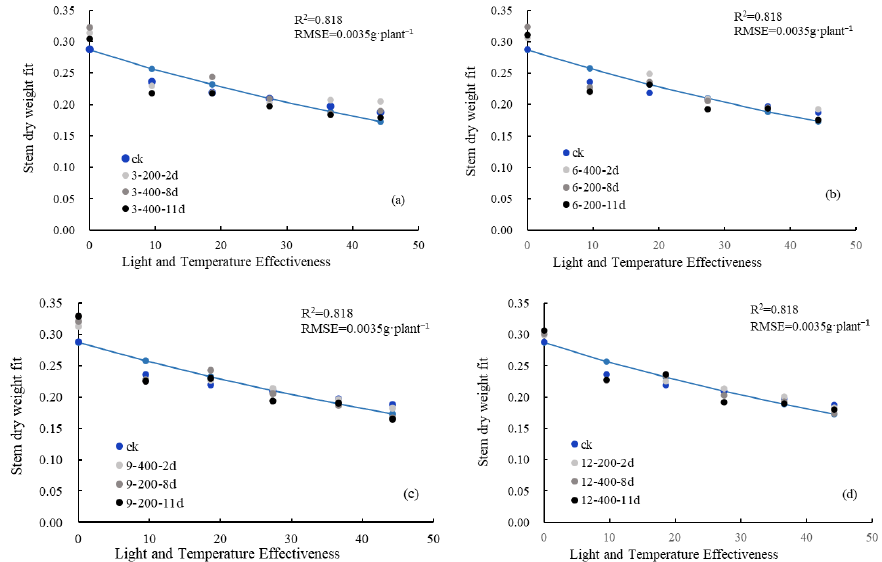
Figure 8. The relationship between the steam dry weight distribution ratio of cucumbers and LTE under LT and PL stresses. ( a ) Changes in steam dry weight distribution ratio with LTE under 3 °C treatments. ( b ) Changes in steam dry weight distribution ratio with LTE under 6 °C treatments. ( c ) Changes in steam dry weight distribution ratio with LTE under 9 °C treatments. ( d ) Changes in steam dry weight distribution ratio with LTE under 12 °C treatments. Note: Control represents the variation in stem dry weight fit (proportion) per cucumber plant with the increase in LTE under normal growth